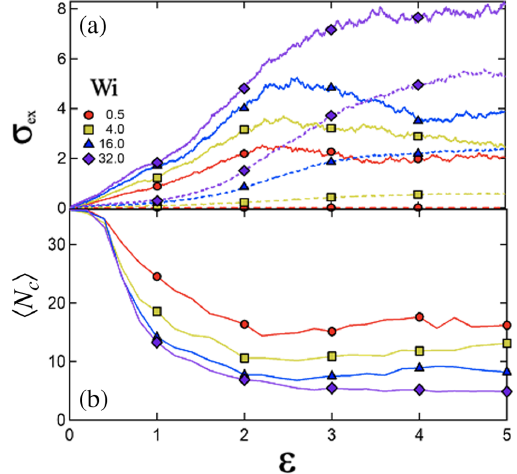
FIG. 4. (a) Extensional stress σ (dashed lines) and 6 (solid lines) and (b) average cluster size h N as a function of strain ε for α ¼ 6 and Wi ¼ 0 . 5 , 4, 16, and